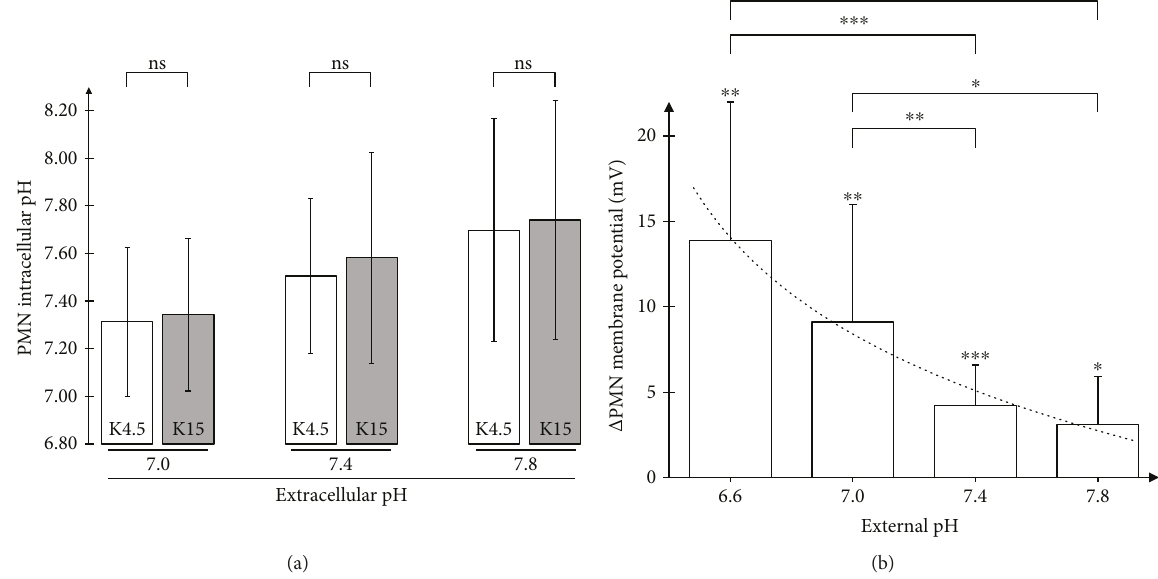
Figure 4: (a) Independency of intracellular pH from forced depolarization. PMN with di ff erent external pH, each with K4.5 (gray column) and K15 (white column) after a 10-minute incubation ( n = 5 ). (b) Dependency of extracellular pH and response to C5a. Comparison of di ff erent external pH in fl uence on the change of membrane potential of human PMN after stimulation with C5a 100ng/ml after 1 minute; n = 8 ; 10 ; 45 ; 9 . The dotted line represents a logarithmic trend line ( R 2 = 0 98 ). ∗ p < 0 05 , ∗∗ p < 0 01 , and ∗∗∗ p < 0 001